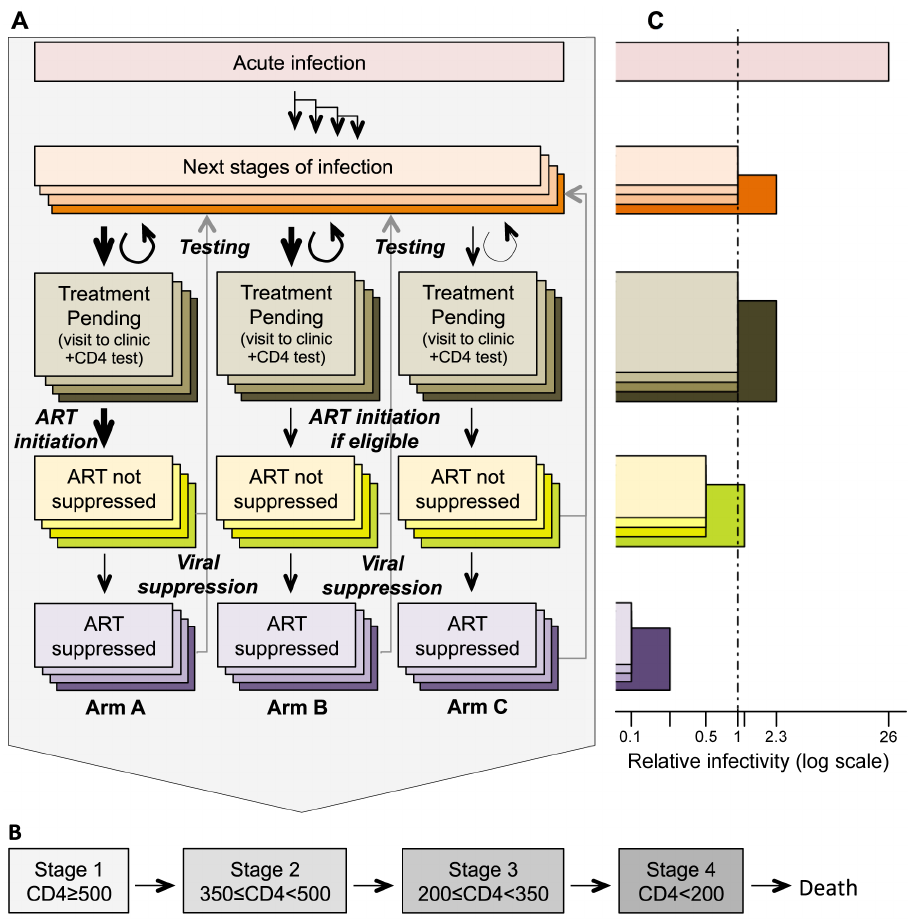
Figure 2. Model structure for infected individuals. A. Flow diagram of the model. The model describes progression through different stages of natural history and treatment. Arrows depict the different flow rates between compartments. Once infected, individuals enter an early/acute infection stage and then progress to death through 4 stages of infection shown in b. At any stage after acute infection, individuals can get HIV tested, following which a proportion of individuals will decide to seek care. Those individuals then enter the ‘‘treatment pending’’ stage, during which they visit the clinic and get assessed towards ART eligibility. Once assessed, all those eligible initiate treatment. Once on treatment, individuals go through a first phase during which viral load is not fully suppressed, before becoming successfully treated, that is, having a negligible viral load. Individuals on ART can drop out of or fail treatment; they then go back to the pre-test stages. B. Flow diagram of the four stages of infection following acute infection and leading to death. Those stages are defined by the level of CD4 in cells/mm3. Individuals can only move from a higher to a lower CD4 count. The rate of progressing through those stages is different for treated and untreated individuals (see File S1). C. Relative infectivity (on the log scale) of the different stages, compared to an undiagnosed individual with CD4 $ 350, not in acute infection. Individuals in acute infection and stage 4 (CD4 , 200) have an increased infectivity. Individuals on ART have a decreased infectivity.